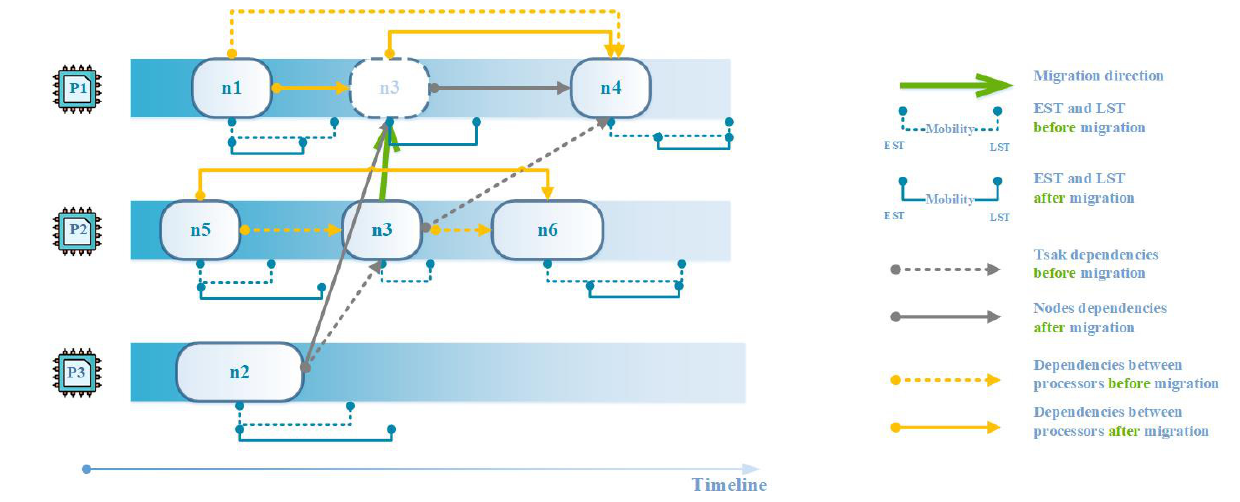
Figure 4. An example of node migration